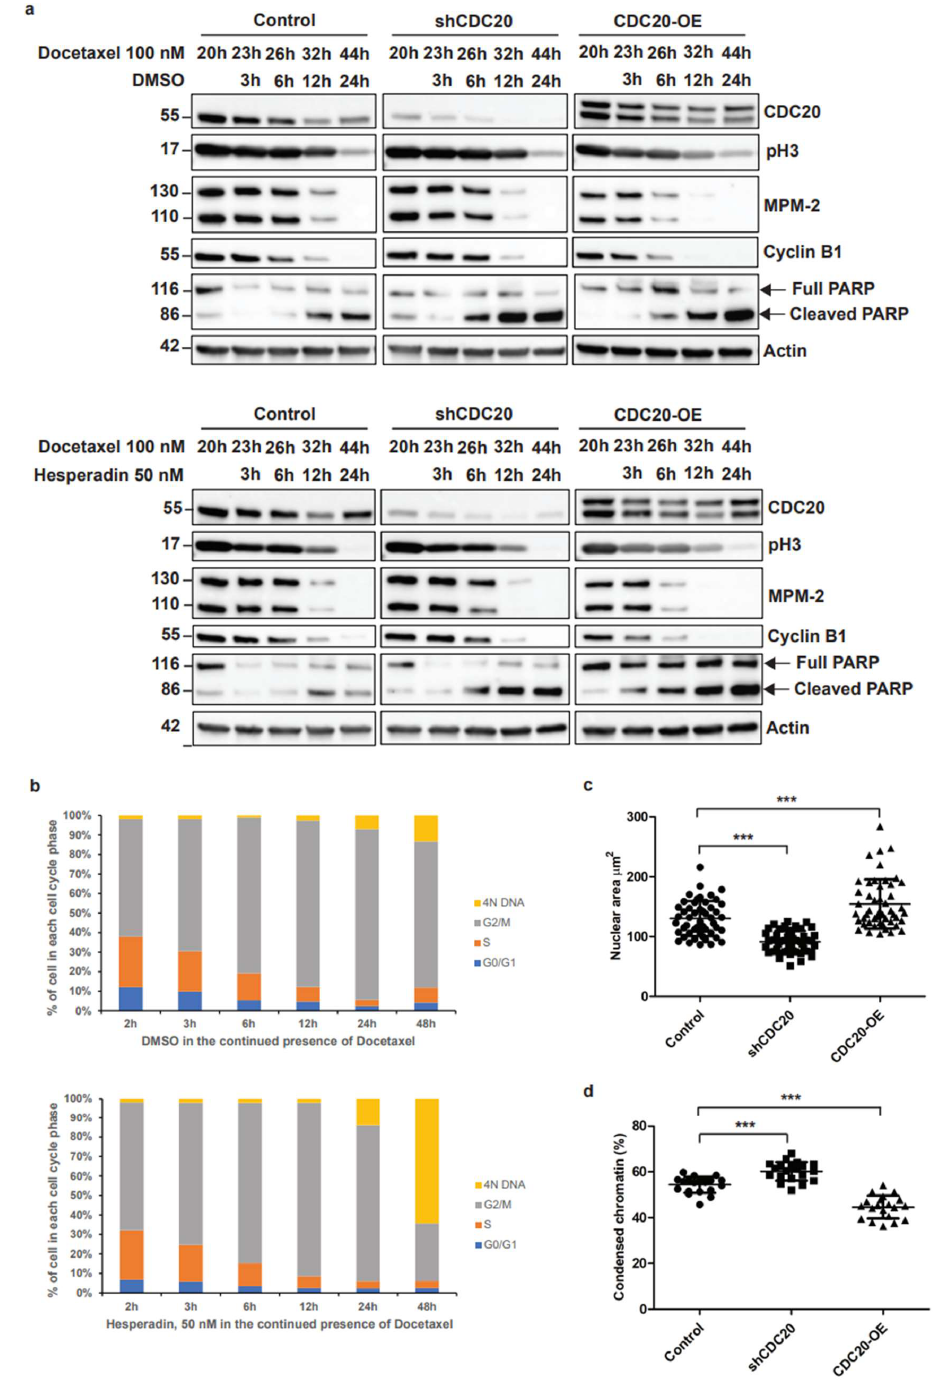
Figure 2. Elevated CDC20 is correlated with mitotic slippage, a possible reason causing an increase in nuclear size and chromatin decondensation in cancer cells. ( a ) MDA-MB-468 cells with CDC20 knockdown (shCDC20) or overexpression CDC20 (CDC20-OE) were pre-treated with 100 nM of docetaxel for 20 h. Pre-treated cells were cultured with either 50 nM of hesperadin or DMSO for 3, 6, 12, and 24 h in the presence of docetaxel. Immunoblot analysis was performed using antibodies against CDC20, pH3, MPM-2, Cyclin B1, PARP, and actin. The levels of pH3, cyclin B1, and MPM-2 were used as mitotic markers. ( b ) MDA-MB-468 cells were pre-treated with 100 nM of docetaxel for 20 h. Pre-treated cells were cultures with either 50 nM of hesperadin or DMSO for 3, 6, 12, 24, and 48 h in the presence of docetaxel. Cells were fixed with ice-cold ethanol, stained with propidium iodide staining